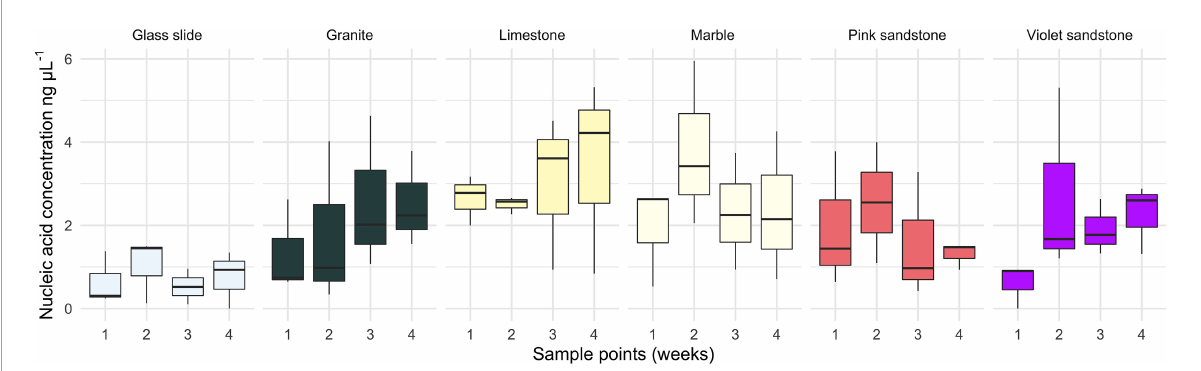
FIGURE1 Box and whisker plot of the biofilm biomass estimates based on total nucleic acid concentration extracted from each time point grouped by substratum. Measured values were obtained using a Qubit fluorescence HS dsDNA kit.